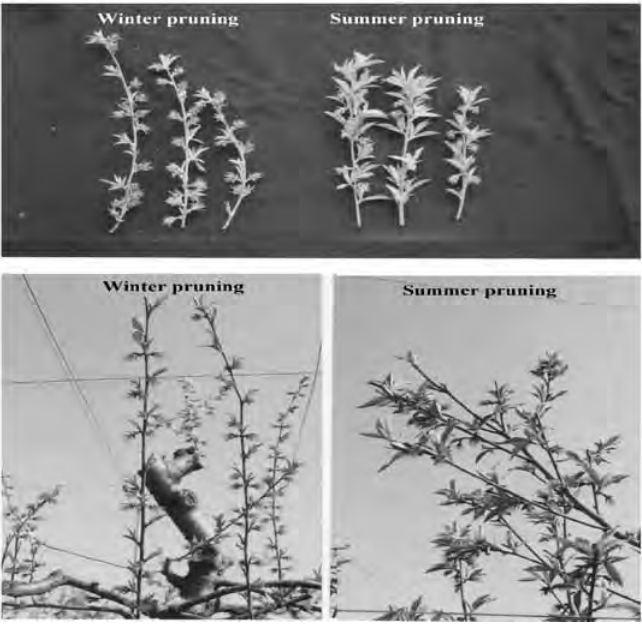
Fig. 3 - Effect of summer and winter pruning on the formation of new shoots, leaves and flowers of peach trees in the following sea - son on April 4.